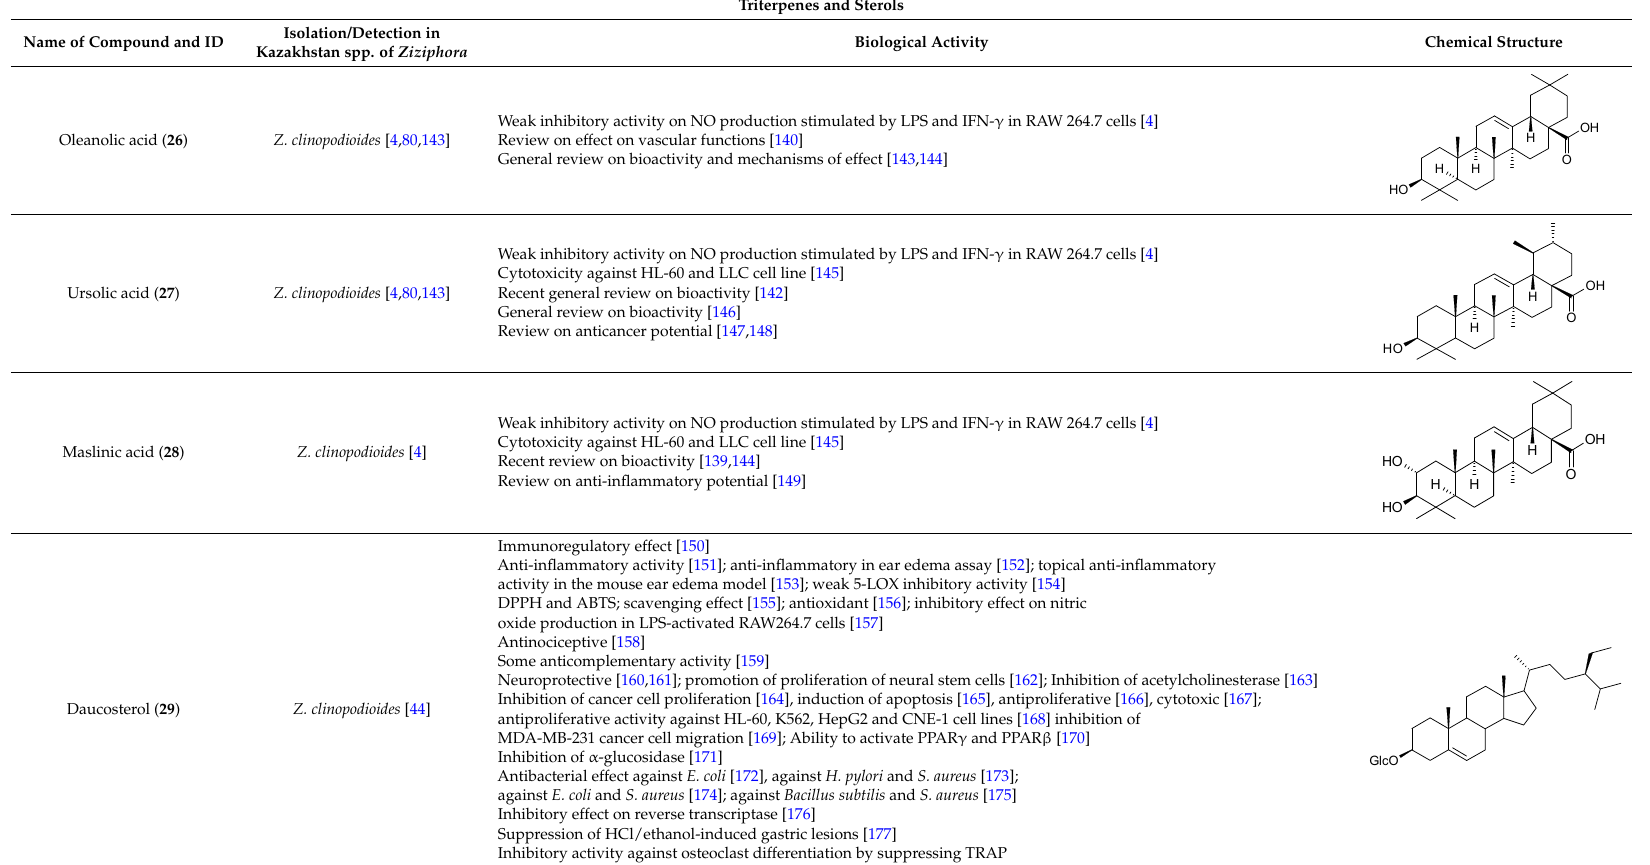
Table 2. Triterpenic substances isolated from Kazakhstan Ziziphora species. (N.f.—not found). Triterpenes and Sterols Name of Compound and ID